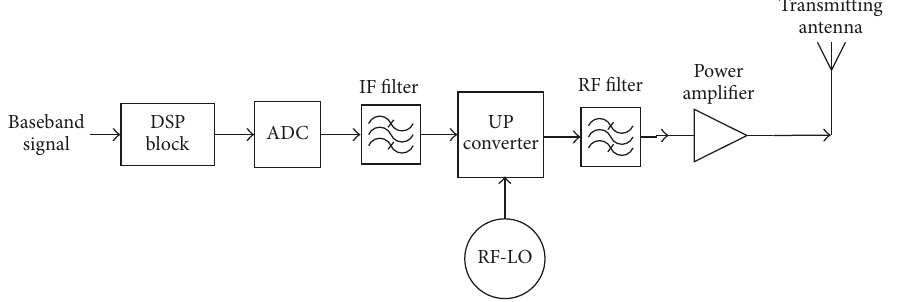
Figure 1: Architecture of radio